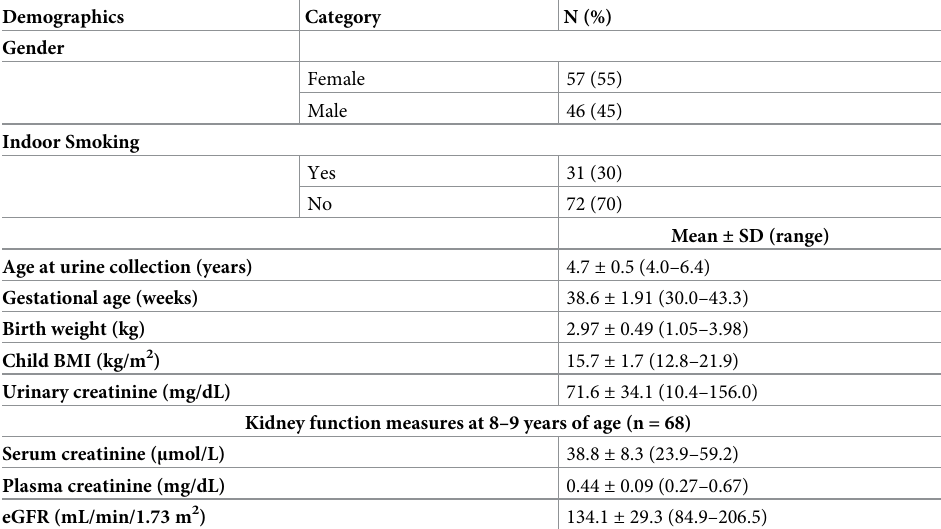
Table 1. Demographic information for 103 children in the PROGRESS study at 4 to 6